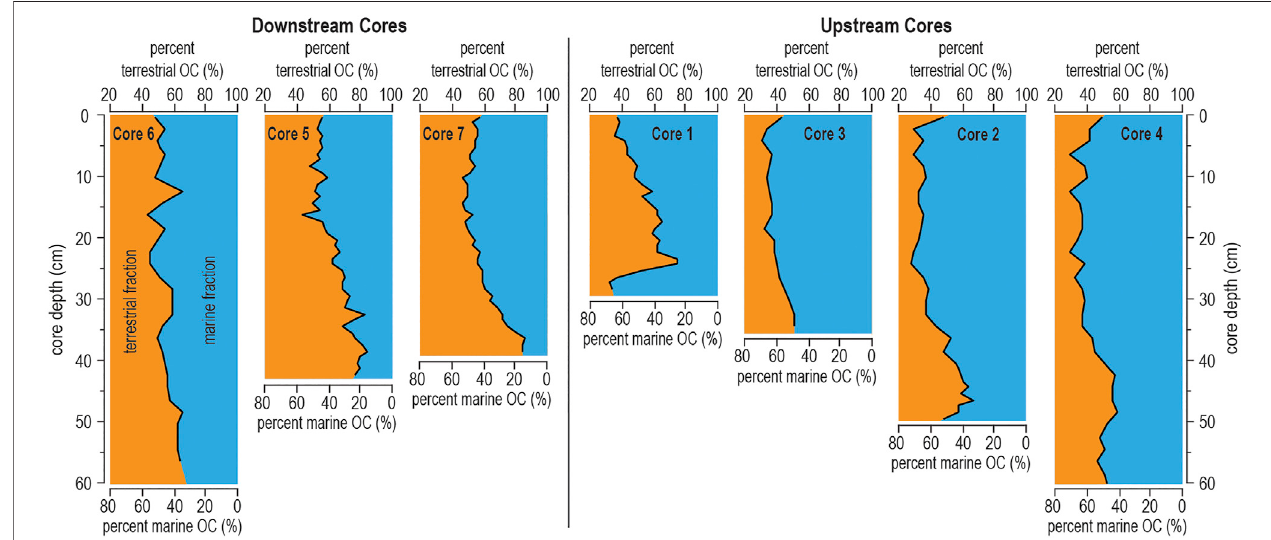
FIGURE4| Isotope mixingmodel results.Downcoretrendsinthepercent terrestrial organic carbon (OC) ascalculatedfromthe δ 13 C org valuesusingasimpletwo- source mixing model. The terrestrial endmember value is δ 13 C org (cid:2) − 28.2 ‰ , as the mangrove vegetation reported by Gonneea et al. (2004), while the marine endmember is δ 13 C org (cid:2) − 20.1 ‰ , as the marine POM along the coast of the Cozumel Channel reported by Brankovits et al. (2017).